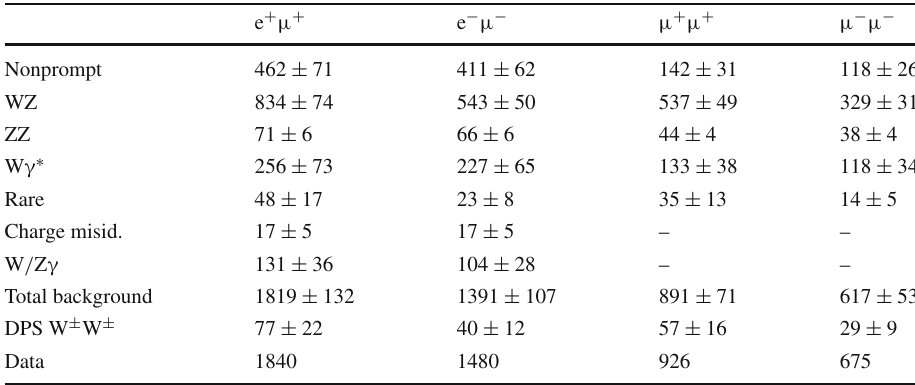
Table 2 Postfit background and signal yields and their uncertainties, and the observed event counts in the four charge and flavor combinations. The uncertainties include both statistical and systematic components. The SHS W ± W